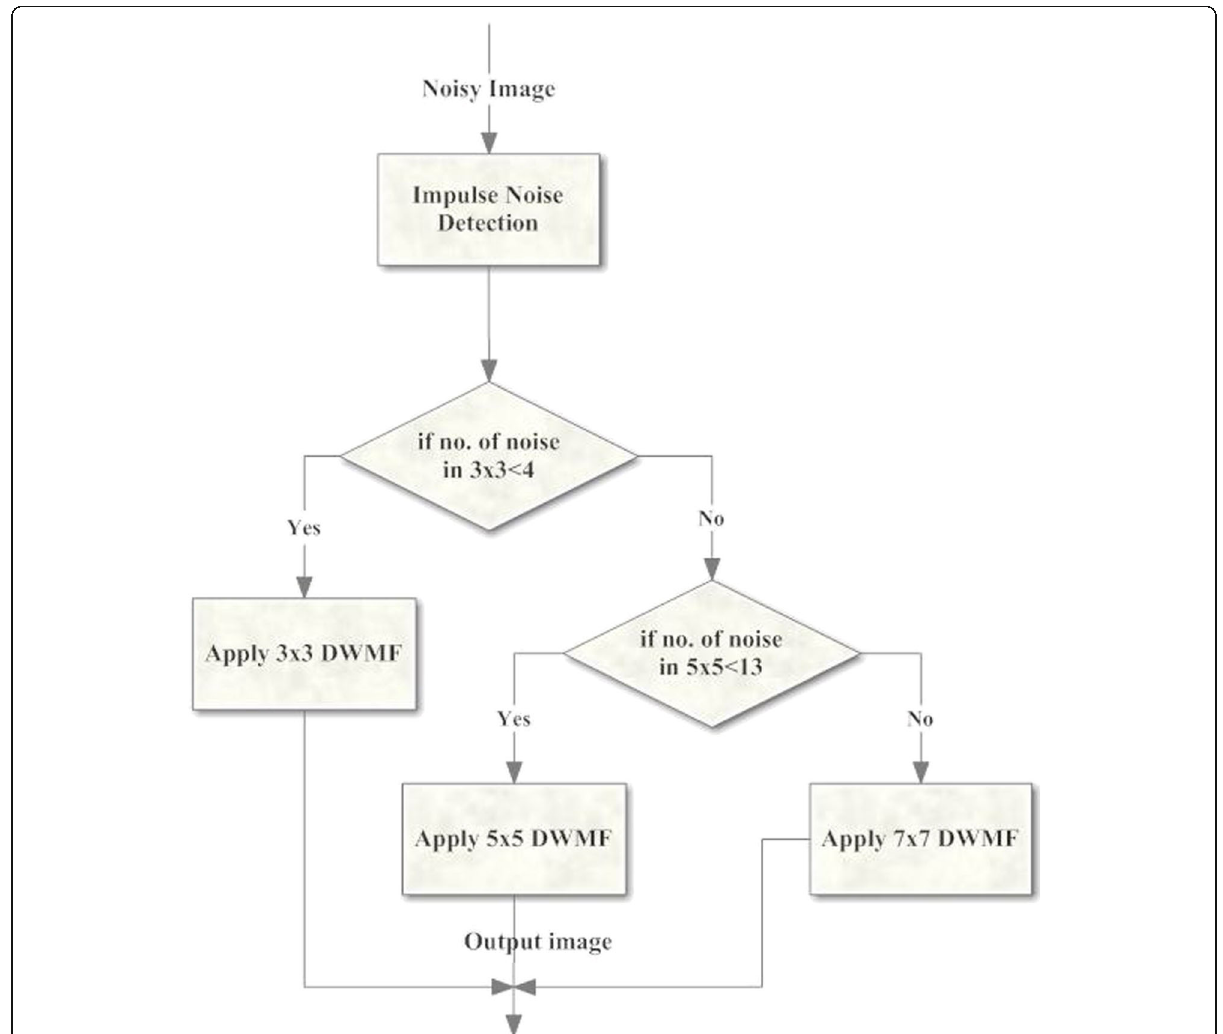
Fig. 5 Flowchart of the proposed ADWMF